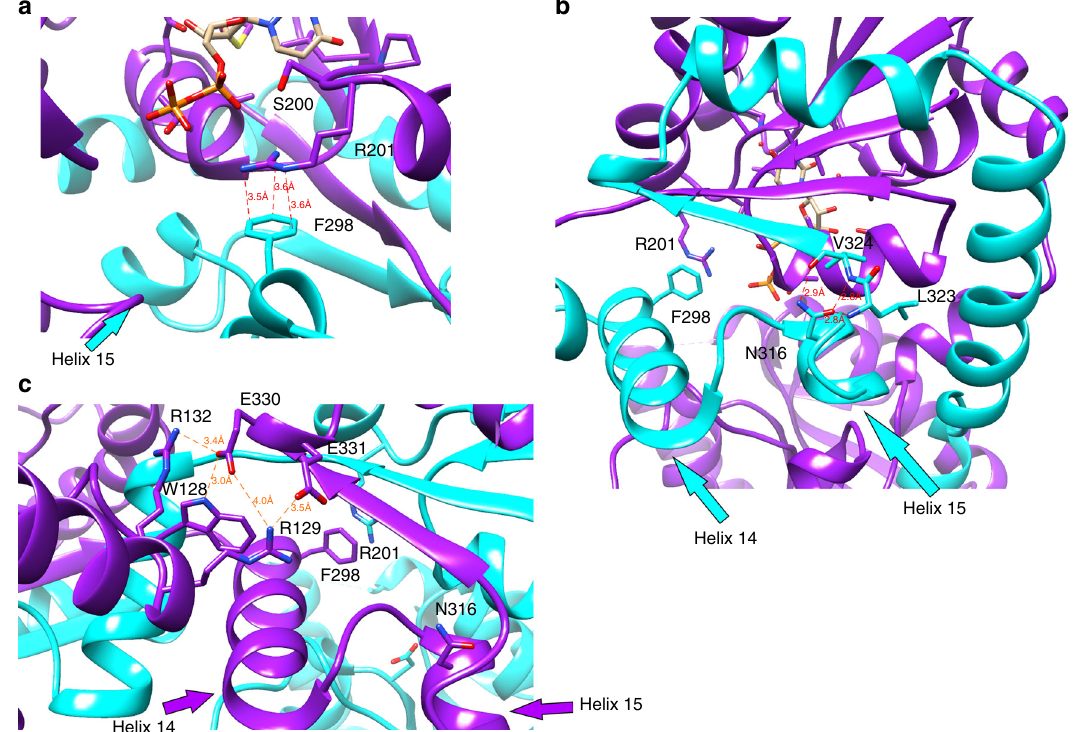
Fig. 4 Interactions that stabilize the dimeric structure. a Position of F298 in relation to the critical residue R201. These residues appear to be engaged in a cation – π stacking interaction with a distance of 3.6 Å between η N1 and ζ C, a distance of 3.5 Å between η N2 and ε C1, and a distance of 3.6 Å between ε N and δ C2. However, the R201 side chain is not fully resolved in the electron density (Fig. 2). The position of helix 15, which contains N316 is also visible. b Position of N316 relative to the crossover helix (helix 14), showing how N316 appears to stabilize the turn from helix 15 to the fi nal strand of the C-terminal β -sheet (strand 13). N316 hydrogen-bonds with the backbone of residues 323 and 324. The interaction distances in angstroms are as follows: N316 δ O to L323 N (2.8), N316 δ O to V324 N (2.8), and N316 δ N to V324 O (2.9). c Interactions between the N-terminal domain and the adjacent C-terminal domain. R129 forms a salt-bridge with E331 (3.5 Å between η N1 and ε O2). E330 forms a salt-bridge with R132 (3.4 Å between ε O1 and η N2) and a hydrogen-bond with W128 (3.0 Å between ε O1 and ε